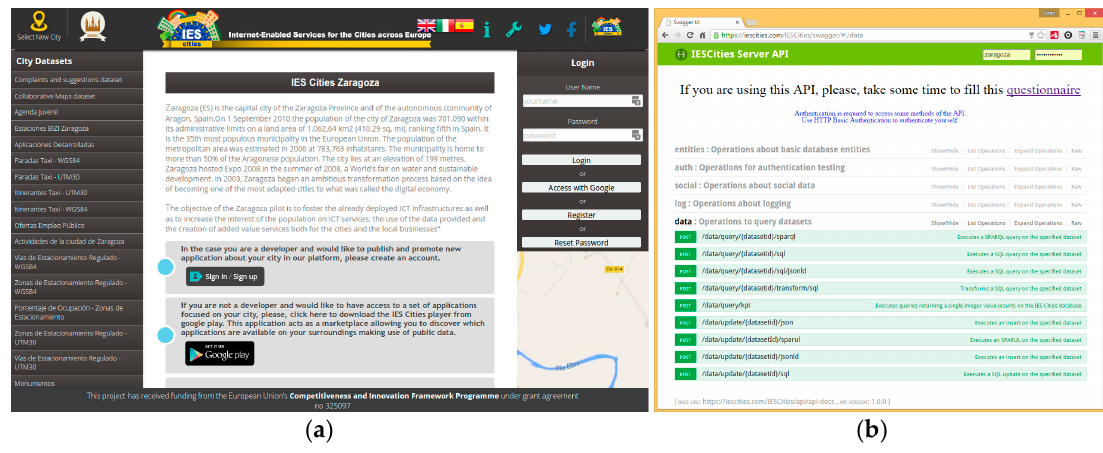
Figure 2. ( a ) Capture of IES Cities’ main web page; ( b ) RESTful API described using Swagger.